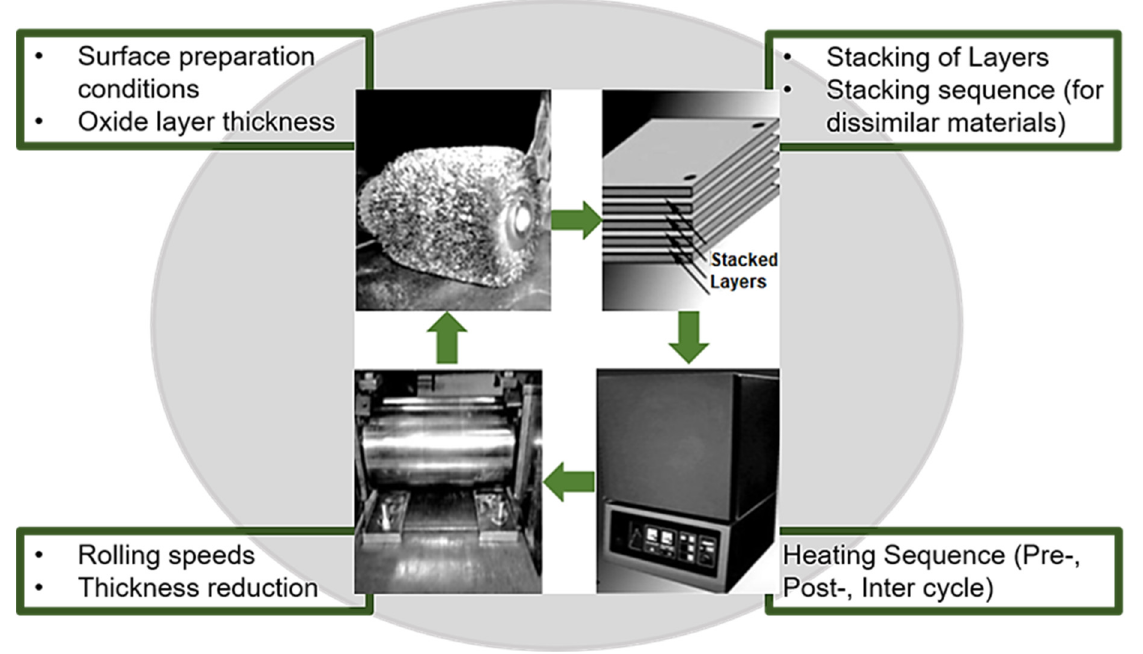
Figure 4. Critical process parameters in different steps of the RB process.